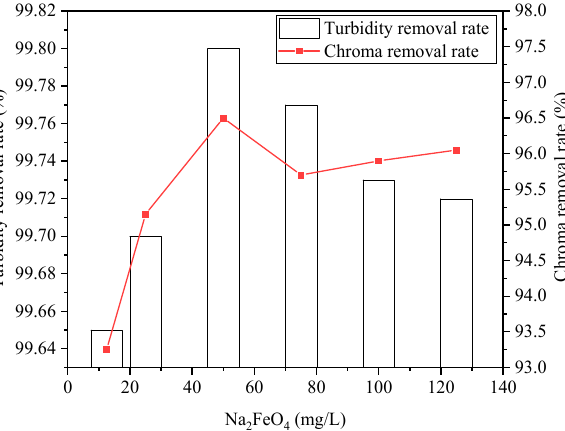
Figure 5. Effect of Na 2 FeO 4 dosage on removal rates of turbidity and chroma.